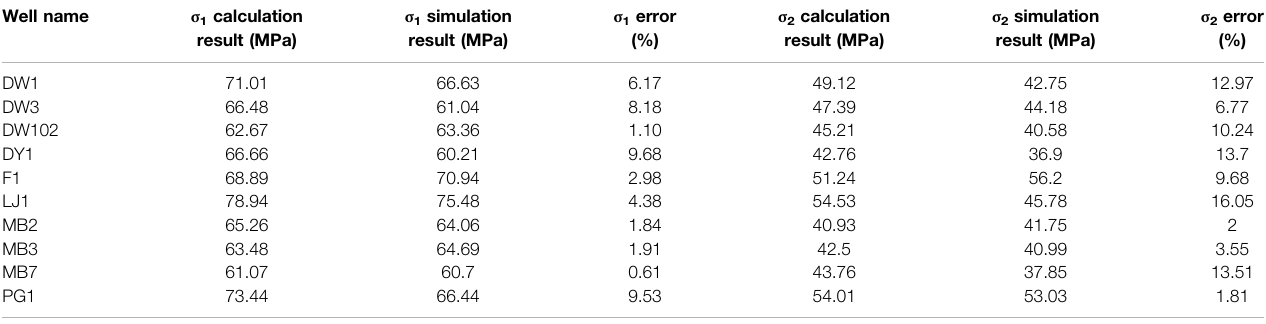
TABLE 2 | Comparative the simulation results and principal stress calculated by logging data. Well name